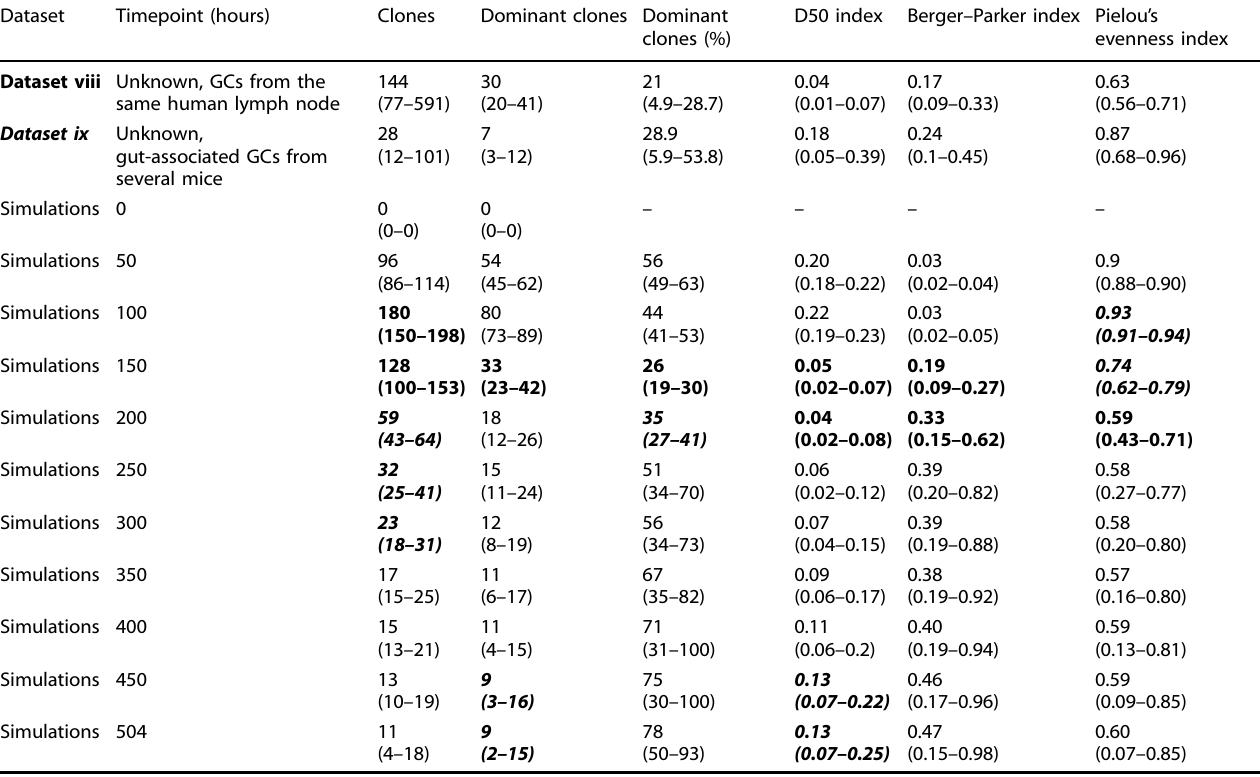
Table 1. Comparison of different timepoints of our simulations with single-GC data at an unknown timepoint (datasets (viii) and (ix)). Dataset